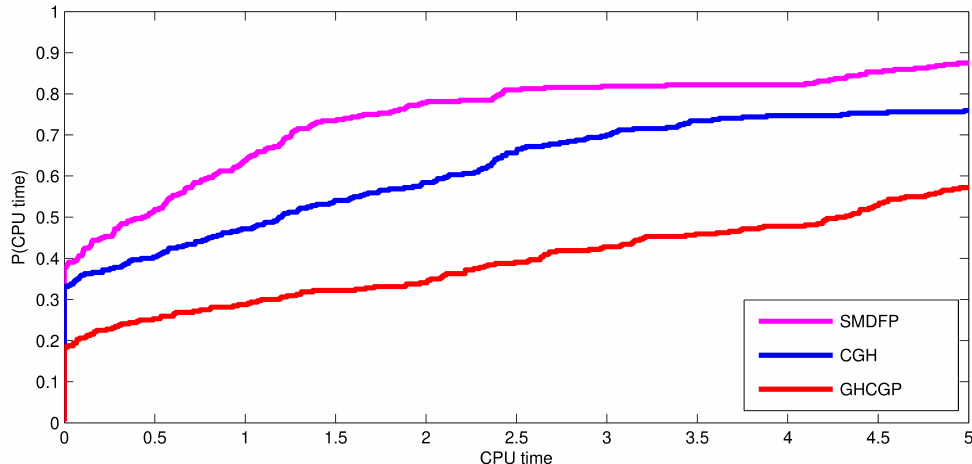
Figure 3. Performance of the SMDFP, CGH [61], and GHCGP [62] methods for the number of CPU